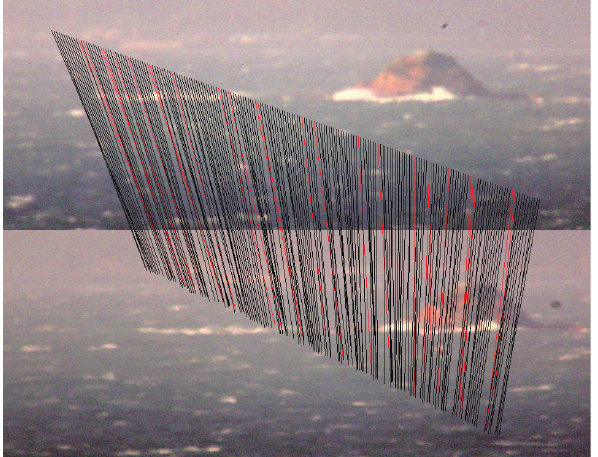
Figure 16. Demonstration of the matching result of pixel points on an oblique line. The top is the image taken by the left camera, and the bottom is the image taken by the right